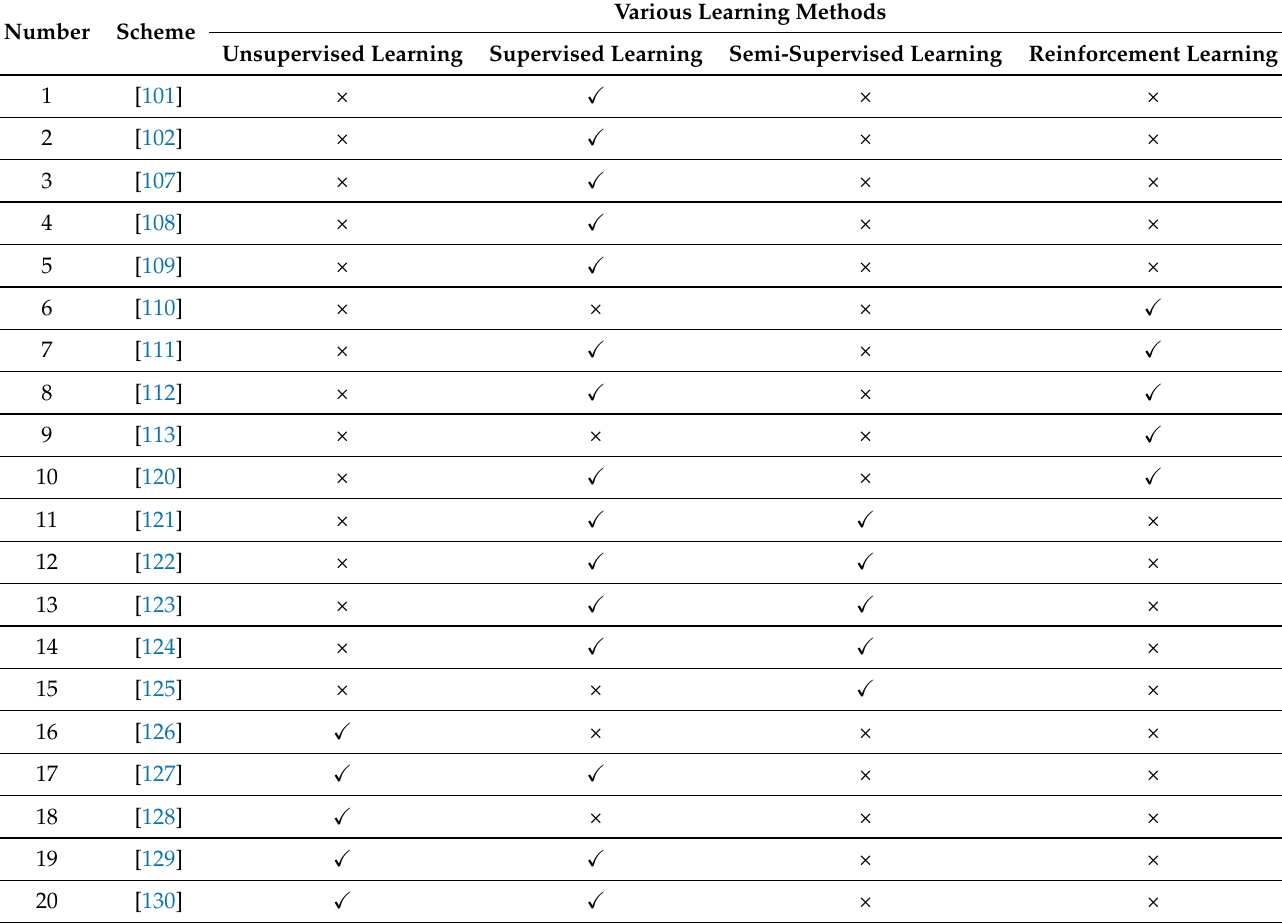
Table 17. Classification of ML-based methods in terms of various learning